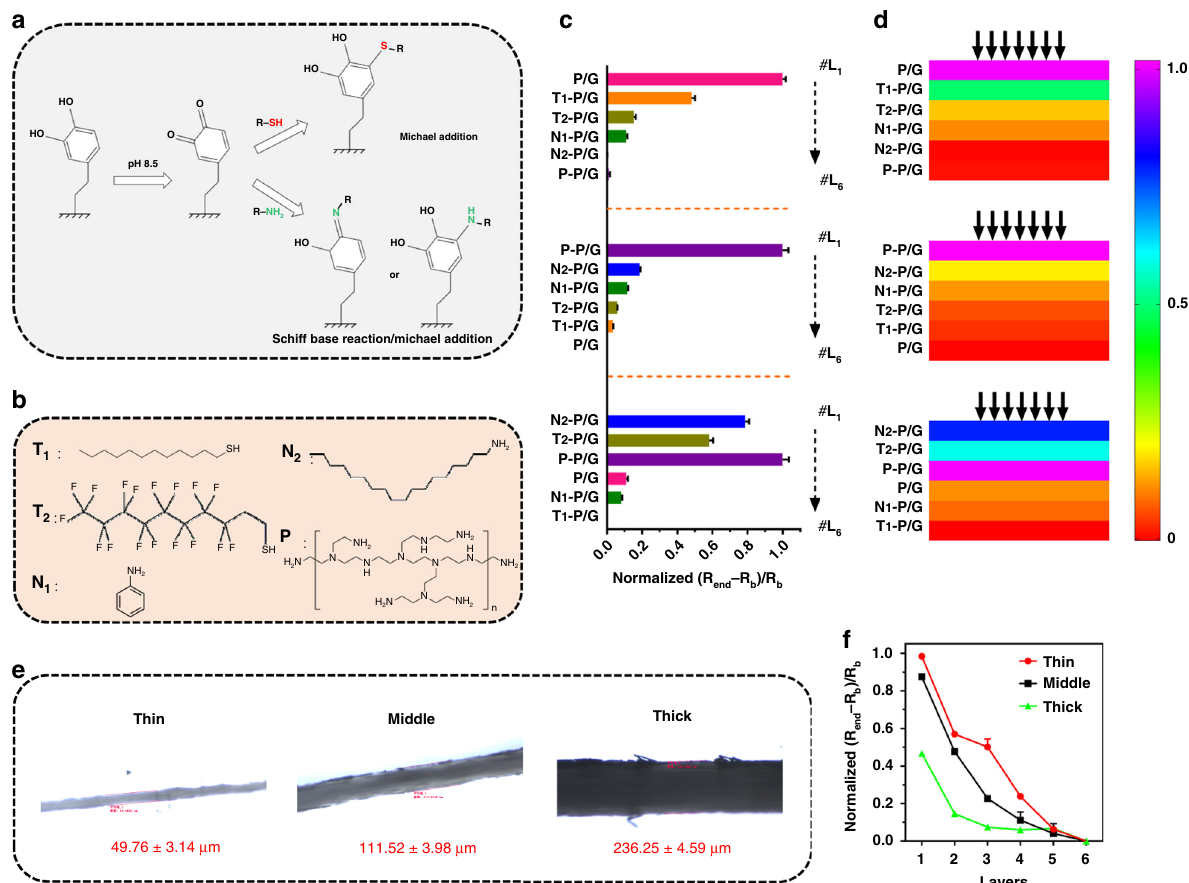
Fig. 5 Tuning the performances of origami hierarchical sensor array (OHSA). a Schematic illustration of the typical chemical reactions of polydopamine with thiol-containing compounds (via Michael addition) and amino-containing compounds (Schiff base reaction/Michael addition). b Structural formula of the chemical ligands used for the functionalization of P/G ink. Bars ( c ) and color maps ( d ) represent the ( R end − R b )/ R b responses of one-sided OHSA written with different functional P/G inks in different orders toward air exposure, respectively. Data are presented as the mean ± SD. e Microscopic measurement of papers of different thickness (thin, middle and thick). f Plots represent the ( R end − R b )/ R b responses of one-sided OHSA by using these papers in diverse tracks toward air exposure. Data are presented as the mean ±